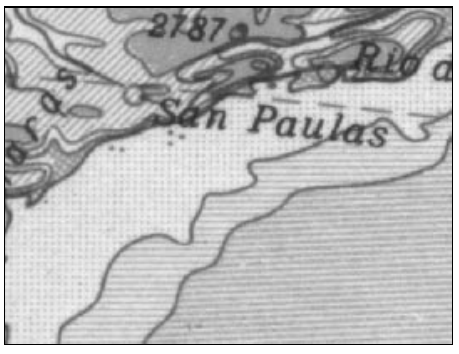
Fig 2. Polygraphical moire Kai kurios skenavimo programos leidžia